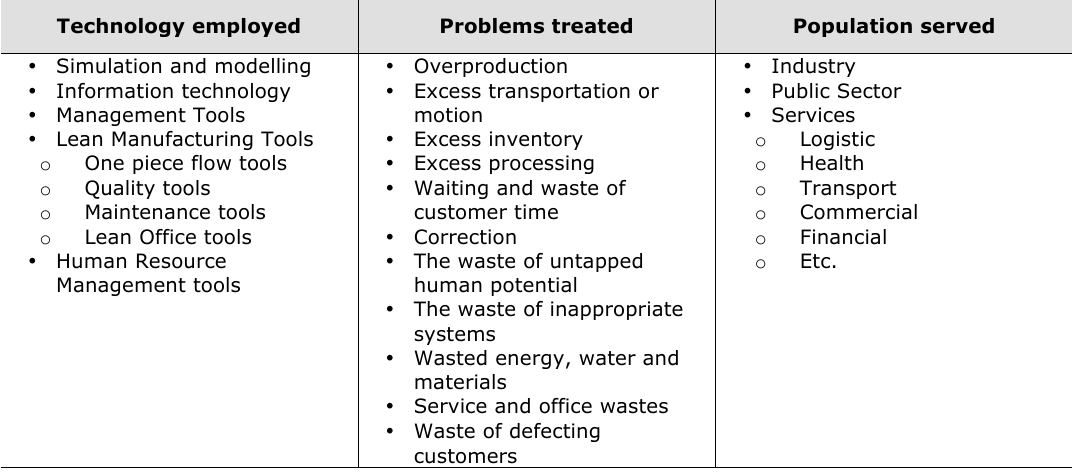
Table 3. “Domain of Industrial